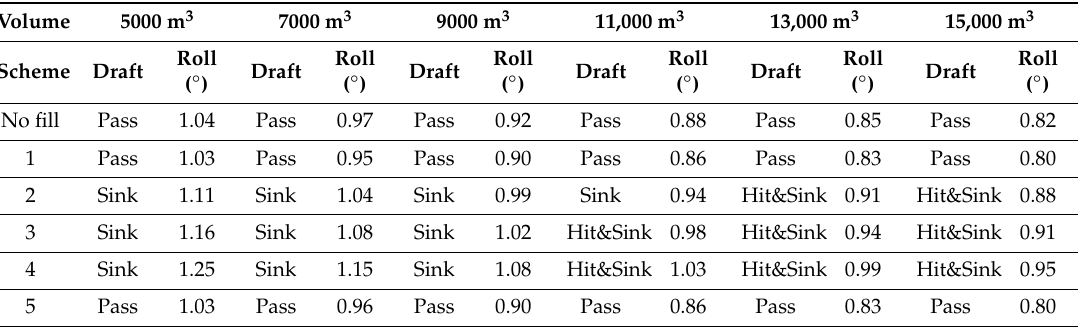
Table 8. Results of storage tank with D / H = 1.6, L / D = 1.05